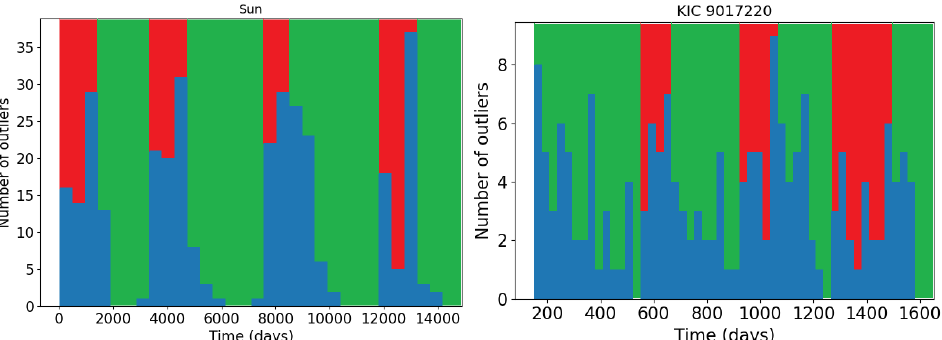
Figure 21. The blue bars are the histogram of outliers of the Sun and KIC 9017220. The red background roughly marks the interval where magnetic activity becomes stronger, and the green marks the interval where it declines,